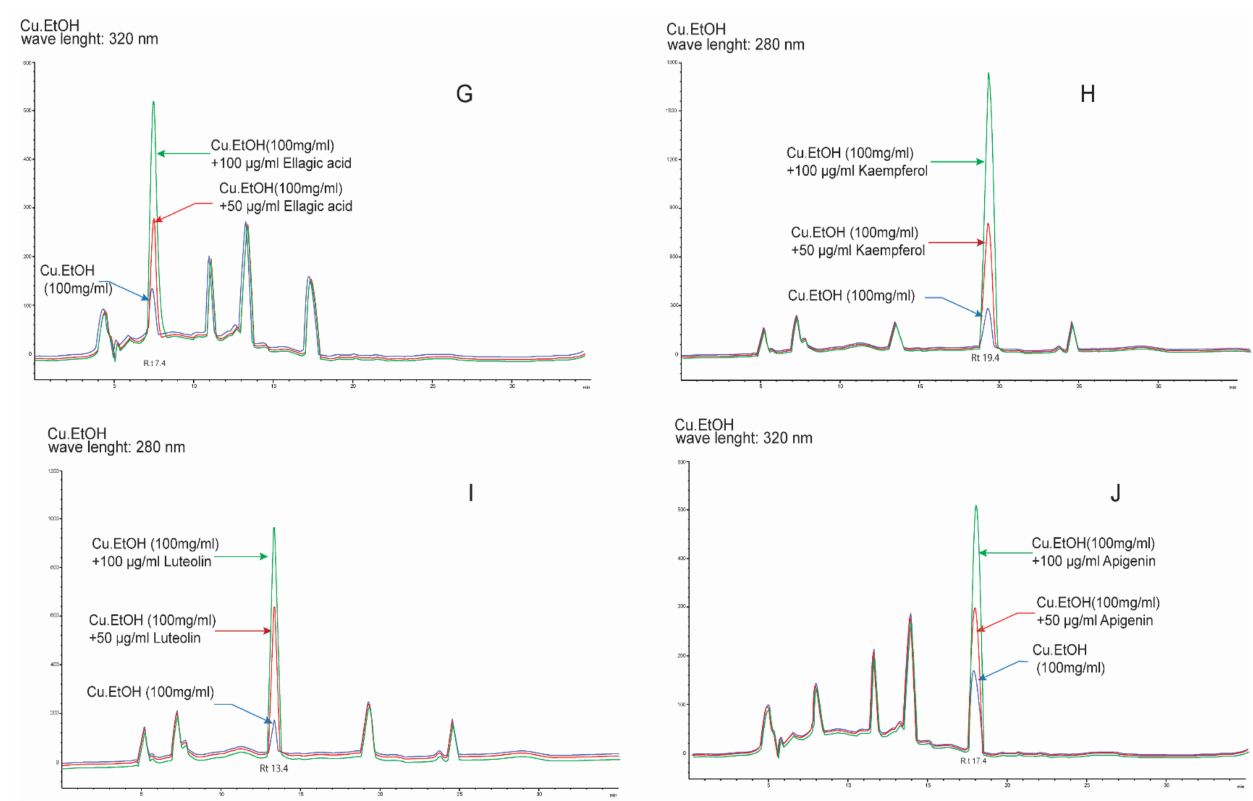
Figure 2. HPLC DAD-UV/Vis chromatograms of a hydroethanolic extract of C. sativus seeds at different wavelengths and standard addition validation chromatograms of bioactive compounds. HPLC chromatogram of ( A ) scopoletin, 1,4- dicaffeoylquinic acid, luteolin, kaempferol, and ferulic acid wavelength 280 nm; ( B ) epicatechin, ellagic acid, kaempferol-3- O -glucoside, quercetin, and apigenin at wavelength 320 nm; ( C ) Stigmasterol and β –sitosterol at wavelength 250 nm. The standard addition chromatograms of ( D ) quercetin; ( E ) kaempferol-3- O -Glucoside; ( F ) 1,4 dicaffeoylqunic acid; ( G ) ellagic acid; ( H ) kaempferol; ( I ) luteolin ( J )